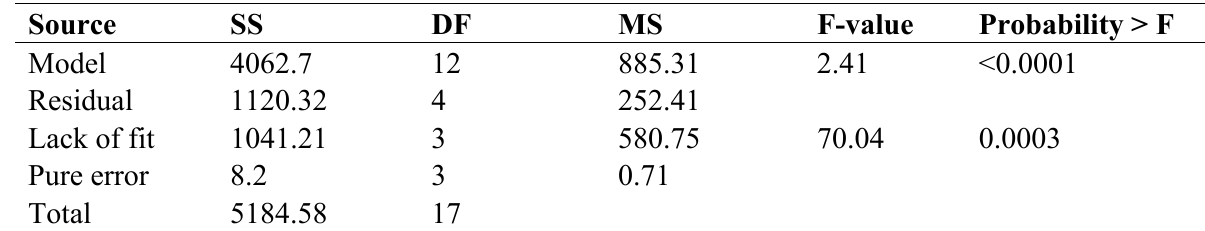
Table 1. Analysis of variance (ANOVA) for response variables (a) Specific activity